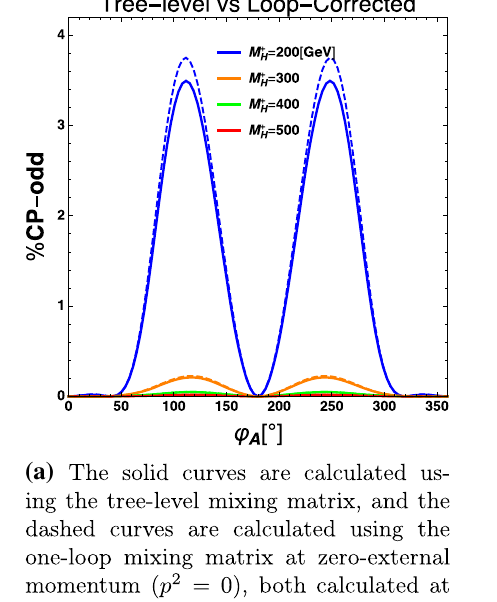
Fig. 7 The other parameters of the scenario are tan β = 5,